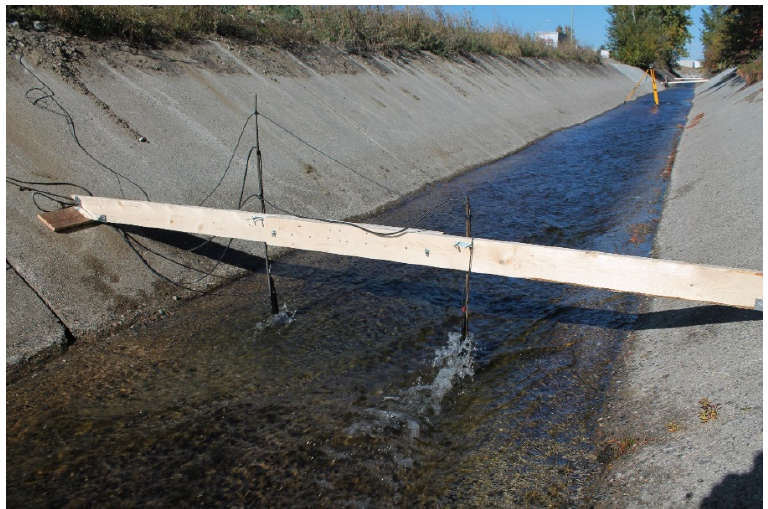
Figure 2. Conductivity sensors in the middle section of the concrete channel, looking upstream toward the injection site in the far distance.